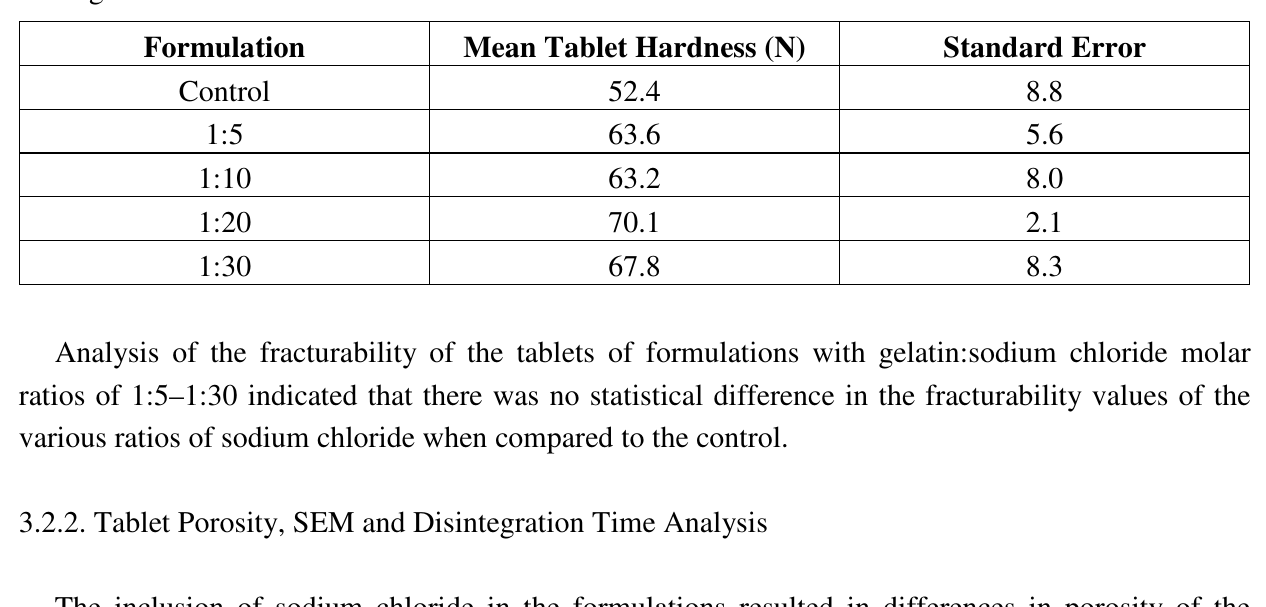
Table 3. Tablet hardness data of the formulations consisting of various ratios of gelatin:sodium